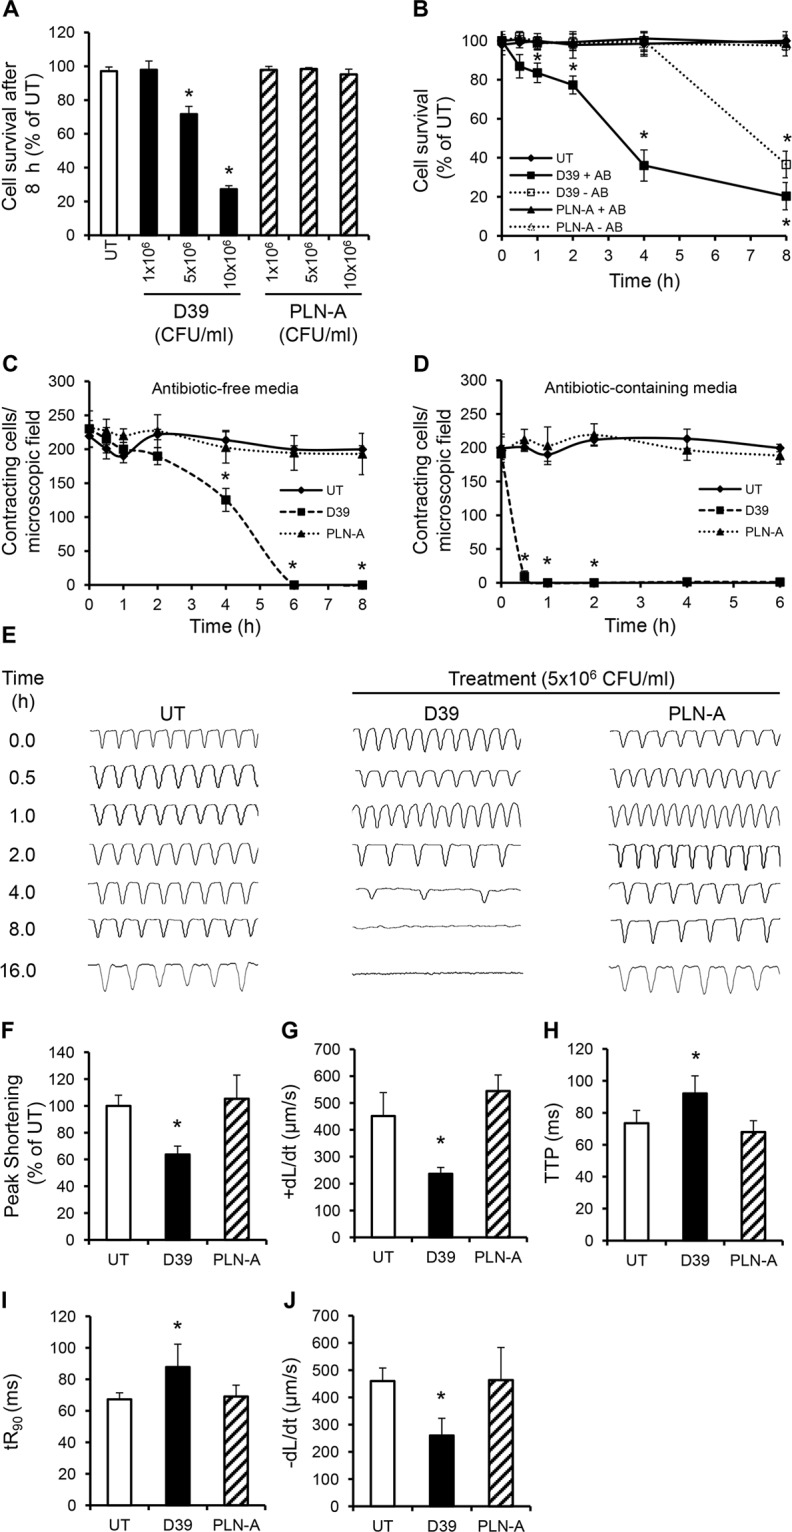
Wild type (D39) but not PLY-deficient (PLN-A) pneumococci cause cardiomyocyte dysfunction and death in vitro.(A) Viability of HL-1 cells was assessed at 8 h after incubation with increasing CFUs of D39 and PLN-A. Viability of untreated cells (UT) was set at 100%. Data are presented as Mean±SD (n = 4). (B) Time course of HL-1 cell viability after incubation with 5x106 CFU/ml D39 or PLN-A in the presence or absence of antibiotics (AB). Data are presented as Mean±SD (n = 4). (C) and (D) Effects of D39 and PLN-A (5x106 CFU/ml) on the total number of spontaneously contracting HL-1 cells over time using antibiotic-free (C) and antibiotic-containing media (D). Data are presented as Mean±SD (n = 4). (E) Effects of D39 and PLN-A (5x106 CFU/ml) on the rhythm and rate of contraction of HL-1 cells over time. Typical traces of spontaneous contraction are presented. (F-J) Effects of D39 and PLN-A (5x106 CFU/ml) on Peak Shortening (F), maximum velocity of shortening (+dL/dt) (G), Time to Peak (TTP) (H), Time to 90%-re-lengthening tR90 (I) and maximum velocity of relaxation (-dL/dt) (J) of HL-1 cells after 4 h treatment are presented as Mean±SD (n = 9 from 3 independent experiments). *ANOVA test, p<0.05.